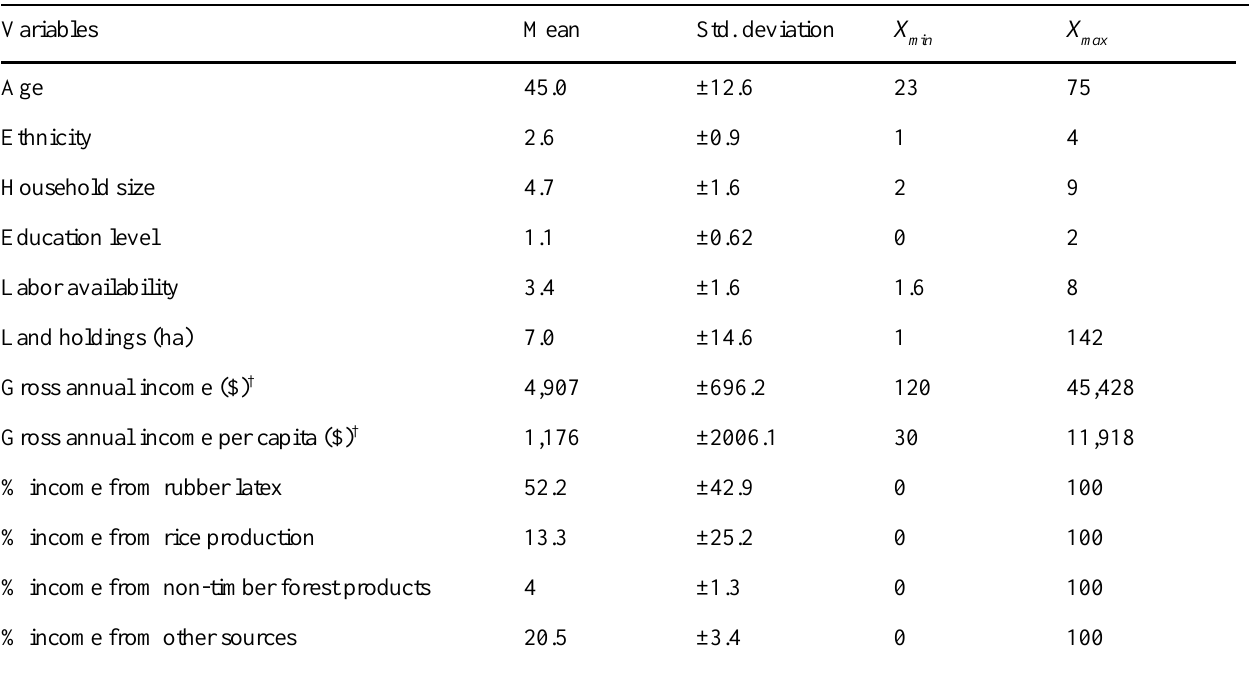
Table 4. Descriptive statistics of the respondents in the study site for 2010 Variables